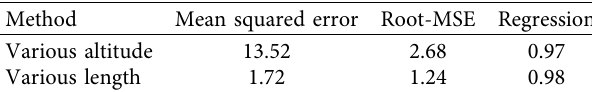
Figure 9: Flowchart proposed ANN Table 1: Calculation of proposed method measurements.